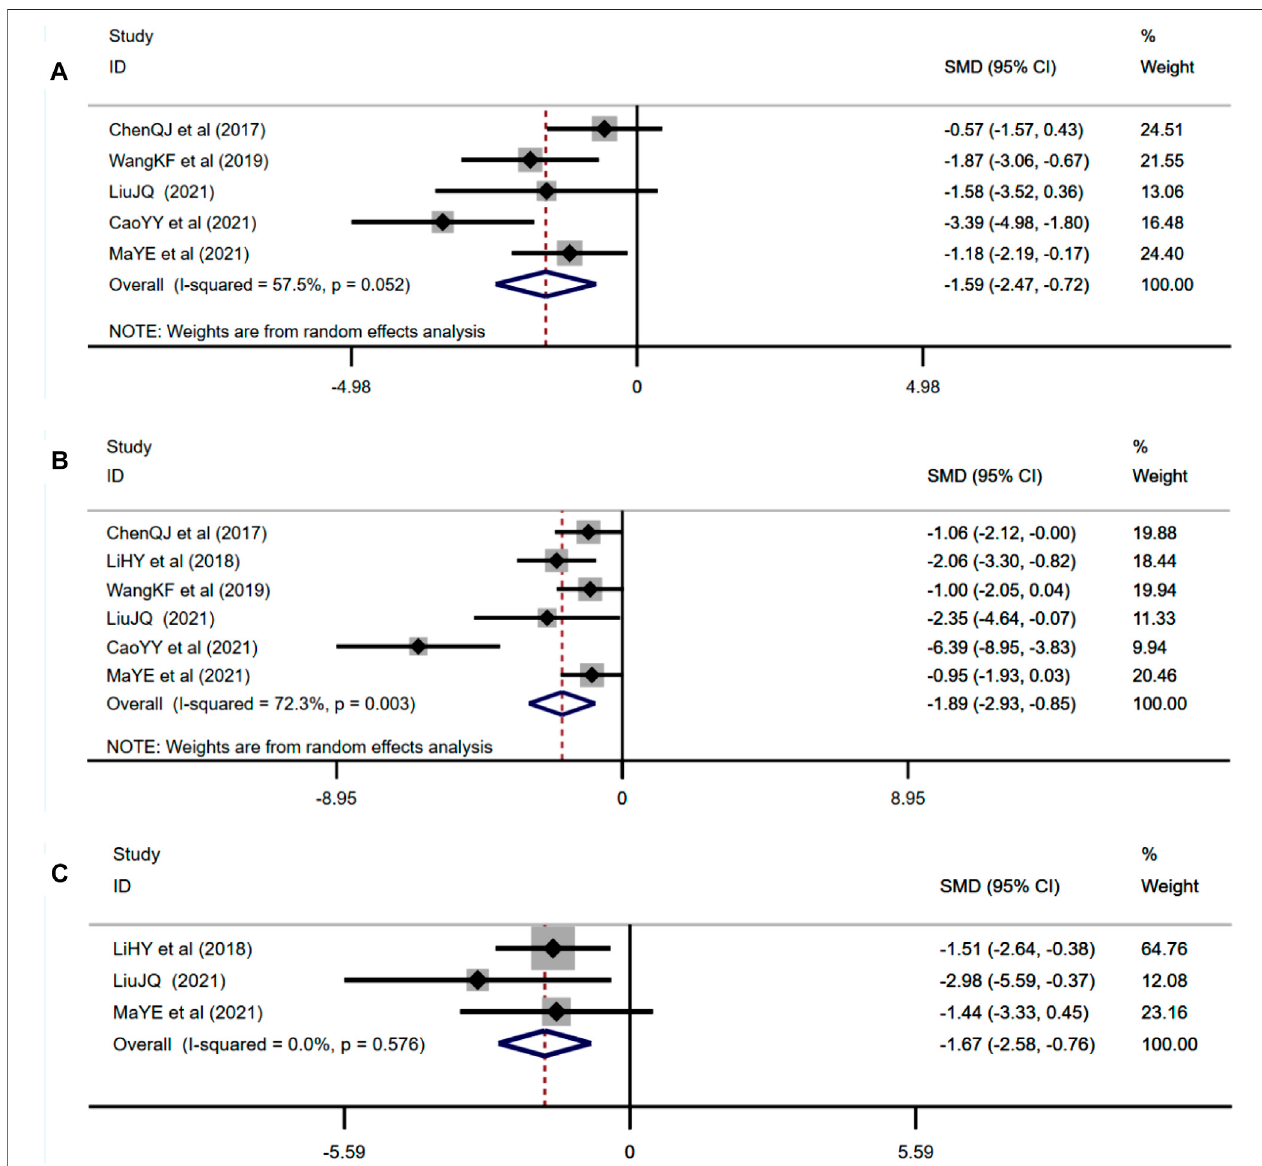
FIGURE 8 | Forest plot: effect of berberine on (A) IL-1 β , (B) TNF- α , and (C) NF- κ B.